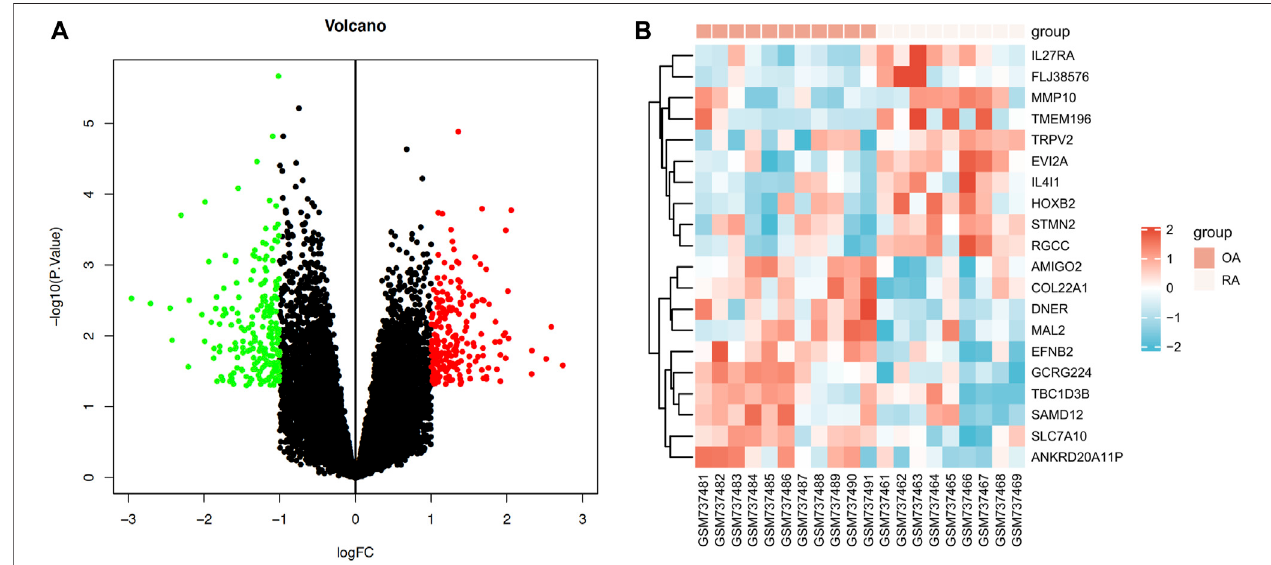
FIGURE 1 | Expression pro fi les of differentially expressed mRNAs (DEGs) in RA. (A) Volcano plot of DEGs (red: upregulated DEGs. green: downregulated DEGs.) (B) Heatmap of the top 10 upregulated DEGs and the top 10 downregulated DEGs (red: high expression; blue: low expression).